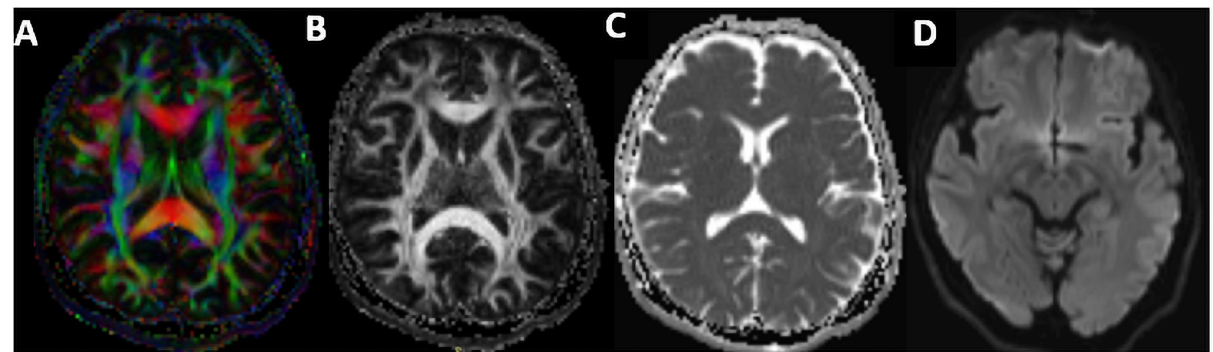
Fig 5. Axial DTI maps of colour FA ( A ), non-colour FA ( B ), ADC ( C ), and trace-weighted ( D